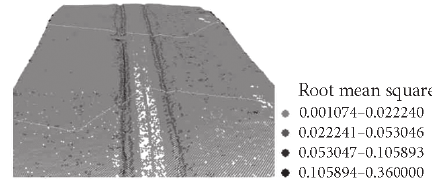
Fig. 2. Rms of plane fitting in the vicinity of the points located at a distance of 0.5 m